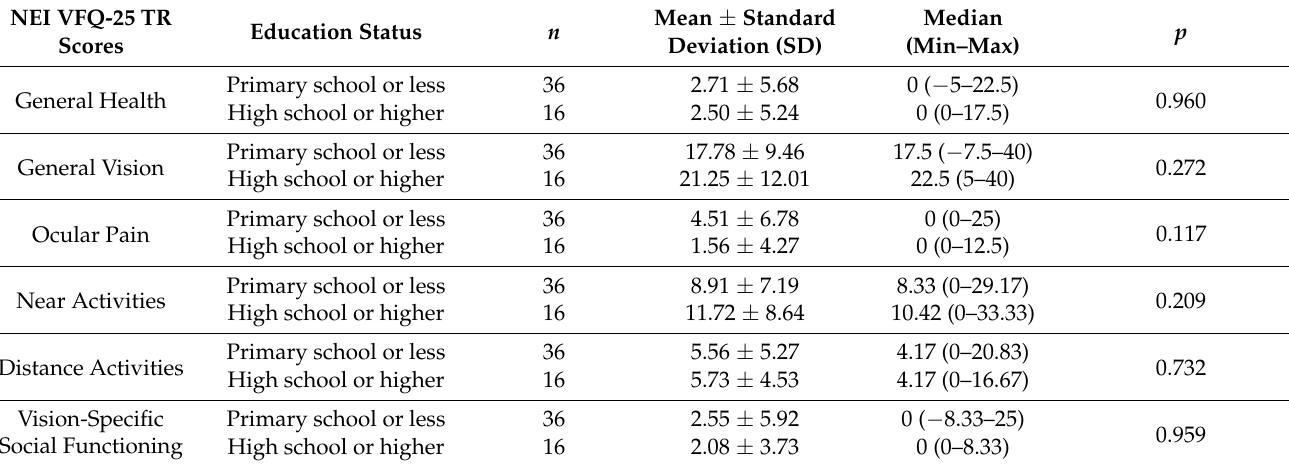
Table 5. Summary of the changes in NEI VFQ-25 TR subscale and composite scores after treatment (1 month after the third injection) according to education